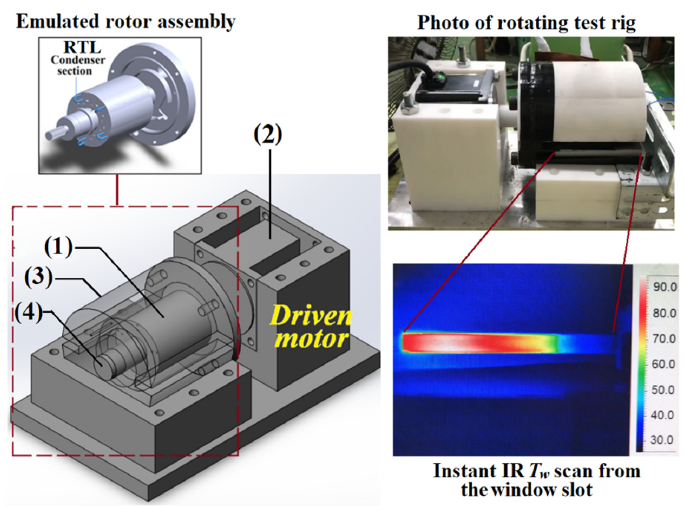
Figure 3. Test rig for measuring Nu inner,AC map on the annular inner surface of the cylindrical air chamber with and without the RTLs.